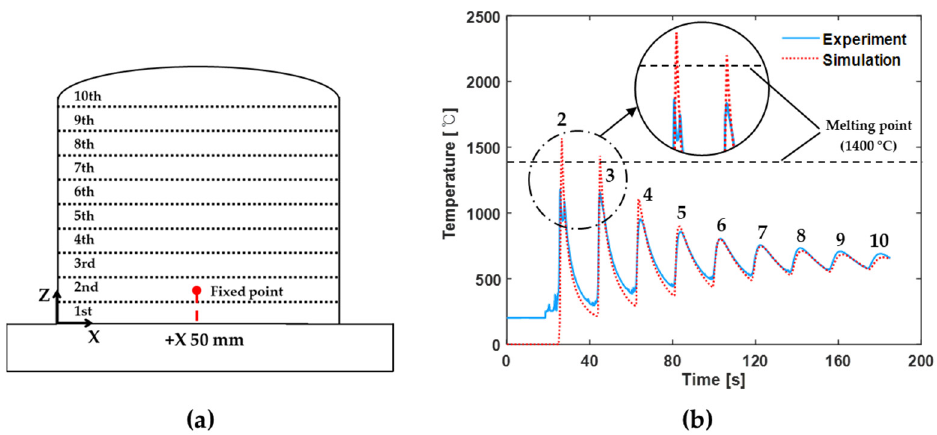
Figure 3. ( a ) Schematic diagram of the temperature measurement position in the CMT-WAAM process; ( b ) comparison of simulated and experimental temperature profiles of the deposit.